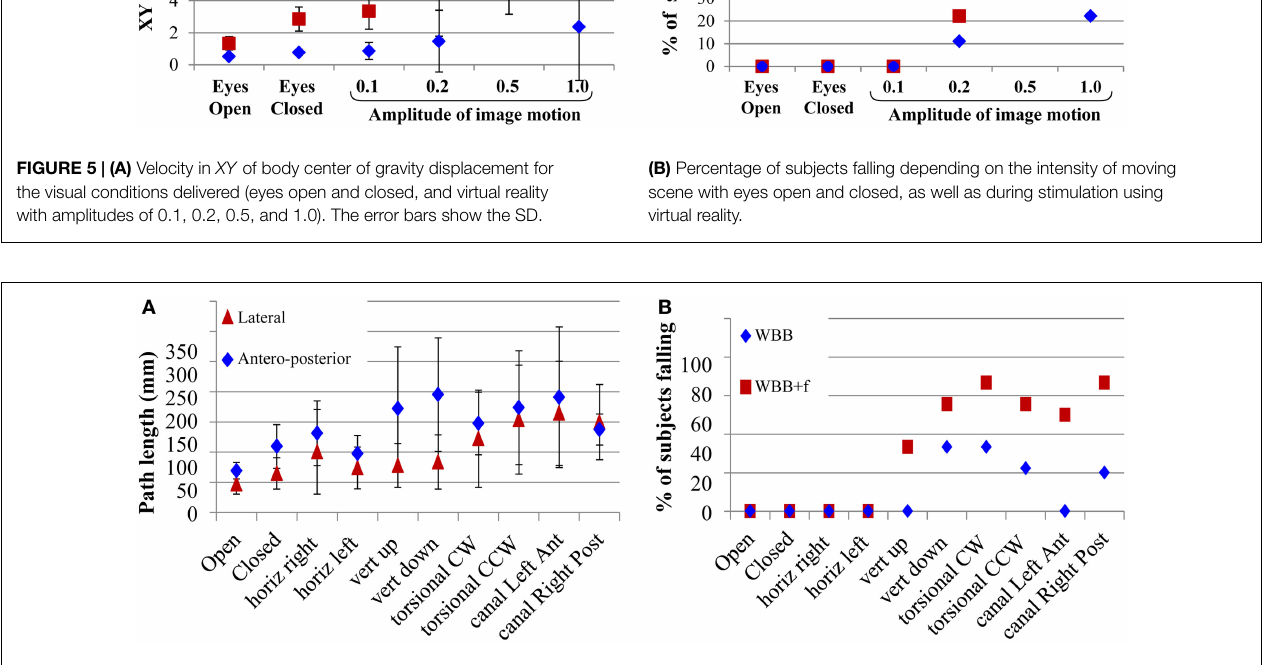
FIGURE 6 | (A) Path length in XY of body center of gravity displacement for the different optokinetic stimulus conditions delivered (Horizontal, vertical up and down, torsional CW and CCW, oblique) on the WBB